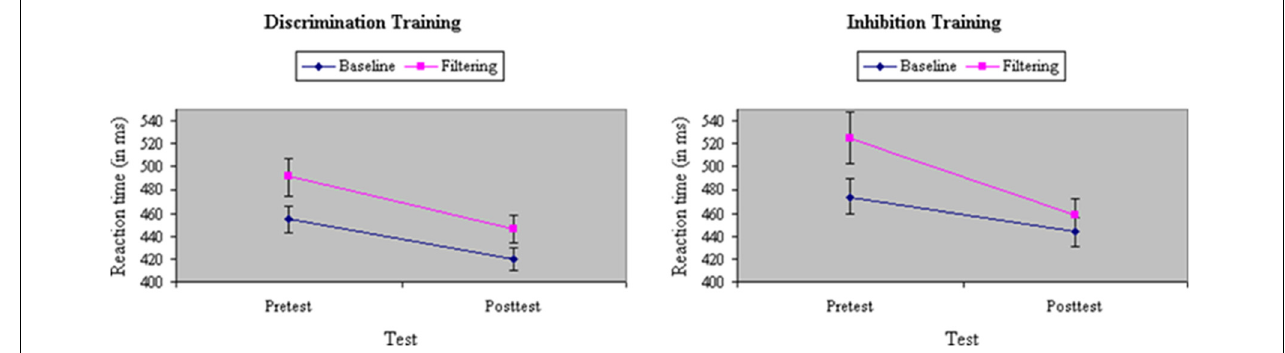
FIGURE 3 | Reaction time (in ms) in baseline and filtering tasks at pretest and posttest in discrimination and inhibition training groups. Participants assigned to inhibition training showed a significantly greater reduction from pretest to posttest in Garner RT interference than participants assigned to discrimination training, yielding a significant Train × Test × Task interaction.